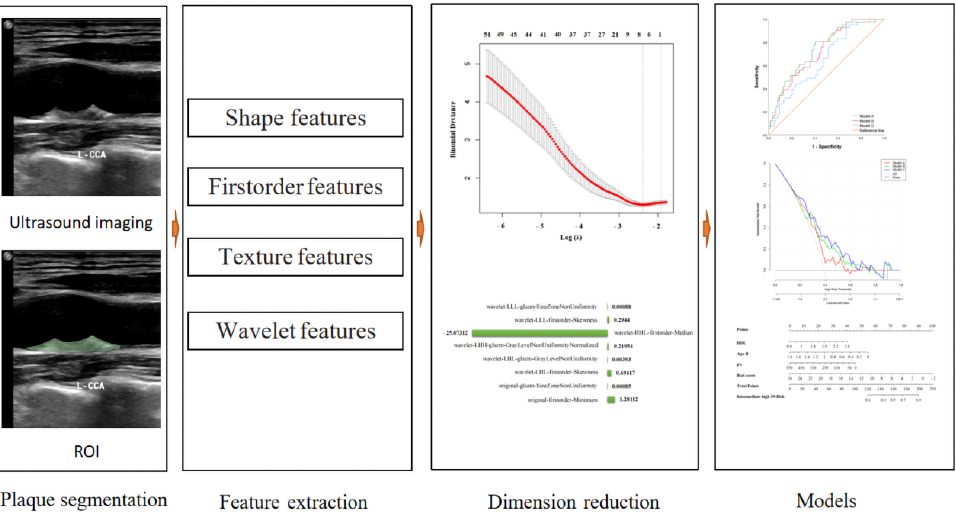
Figure 2. Workflow of the radiomics analysis to distinguish between low and intermediate-high SYNTAX scores.